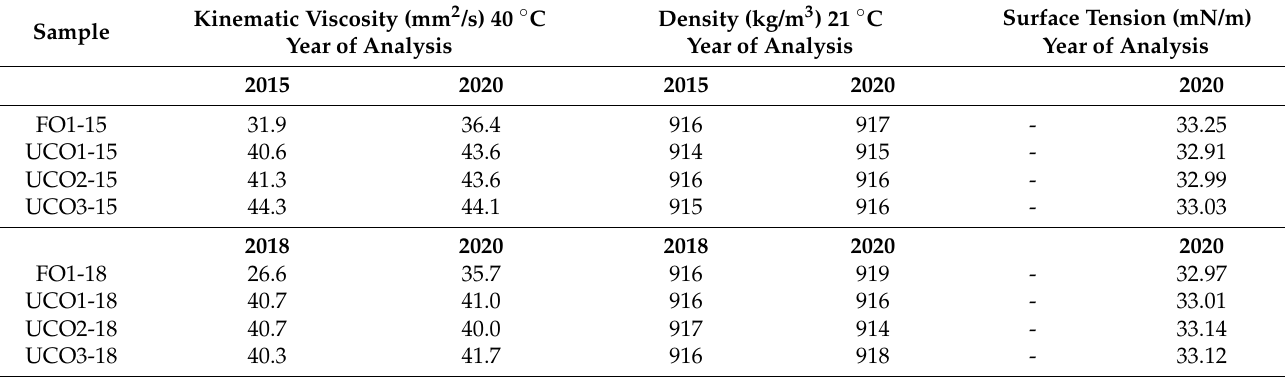
Table 5. Physical properties of bio-oils before and after two and five years of storage. Kinematic Viscosity (mm 2 /s) 40 ◦ Sample